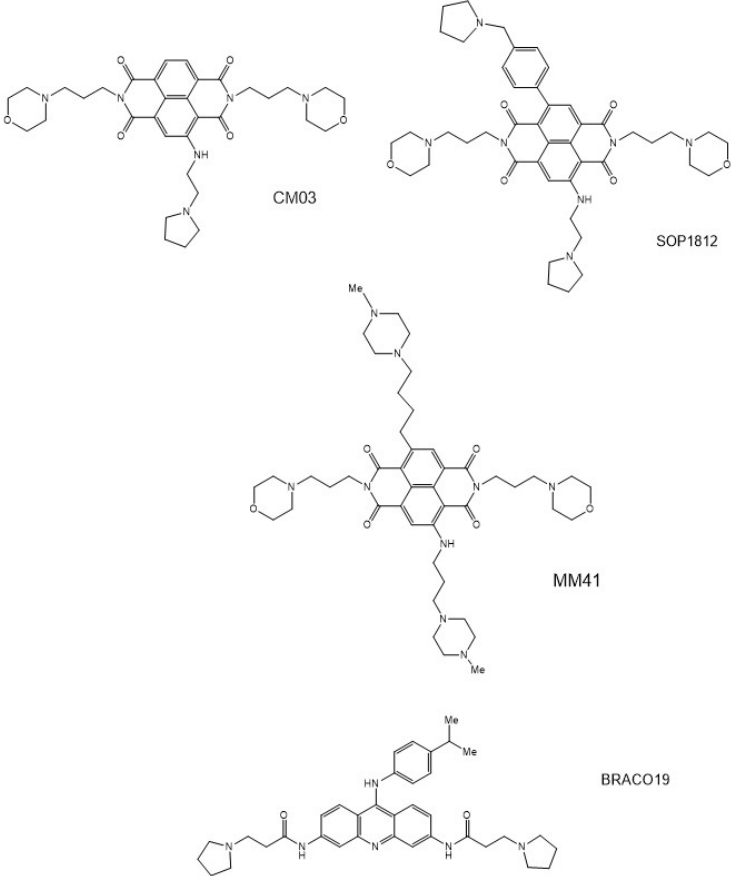
Figure 1. Structures of the tri-substituted naphthalene diimide derivatives (CM03), two tetra-sub- stituted derivatives (MM41 and SOP1812), and the trisubstituted acridine compound BRACO19. CM03: 2,7-bis(3-morpholinopropyl)-4-((2-(pyrrolidin-1-yl)ethyl)amino) benzo[lmn][3,8] phenan- throline-1,3,6,8(2H,7H)-tetraone; SOP1812: 2,7-bis(3-morpholinopropyl)- 4-((2-(pyrrolidin-1- yl)ethyl)amino)-9-(4-(pyrrolidin-1-ylmethyl)phenyl) benzo[lmn][3,8]phenanthroline-1,3,6,8- (2H,7H)-tetraone); MM41: (4,9-bis((3-(4-methylpiperazin-1-yl)propyl)amino)-2,7-bis(3-morpho- linopropyl) benzo[ lmn ][3,8] phenanthroline-1,3,6,8(2H,7H)-tetraone); BRACO19: 3,6-bis(3-pyrroli- din-1-ylpropionamido)-9-(4-dimethylaminophenylamino) acridine.